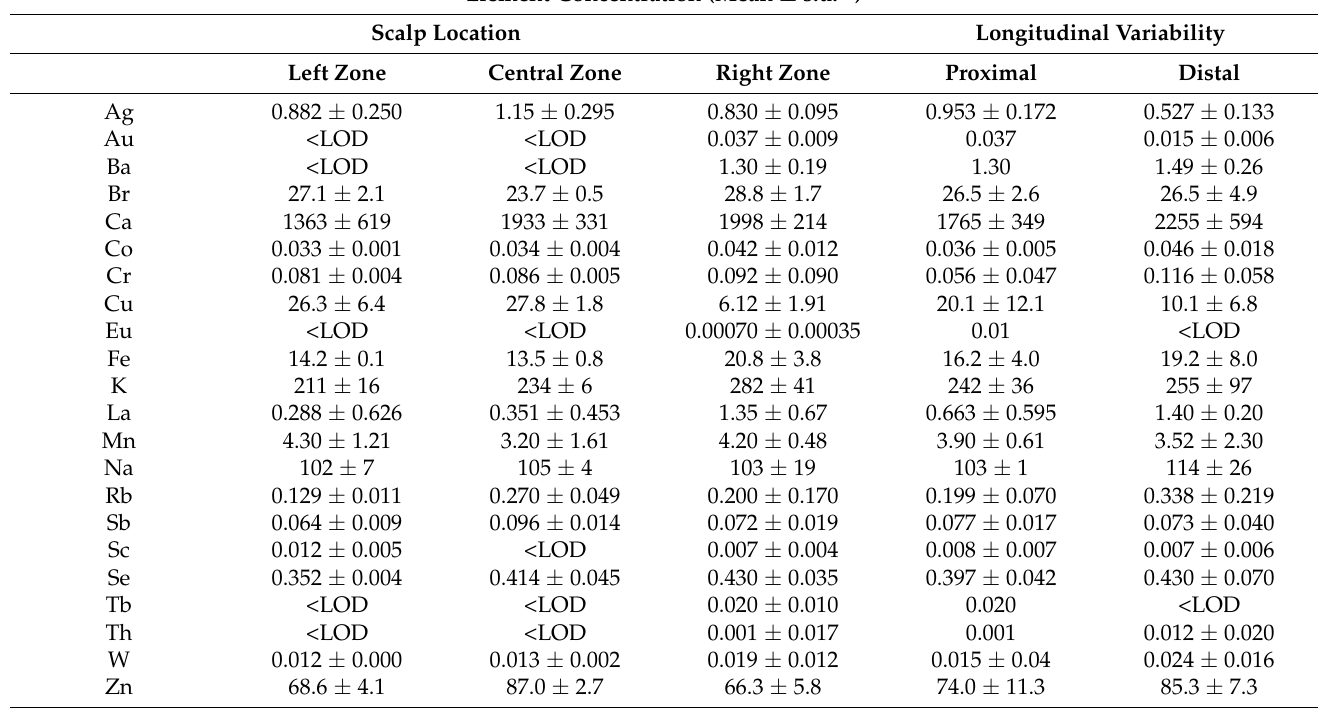
Table 3. Element concentrations ( µ g g − 1 ) in the nape different areas and along the hair (proximal and distal zones), (five independent